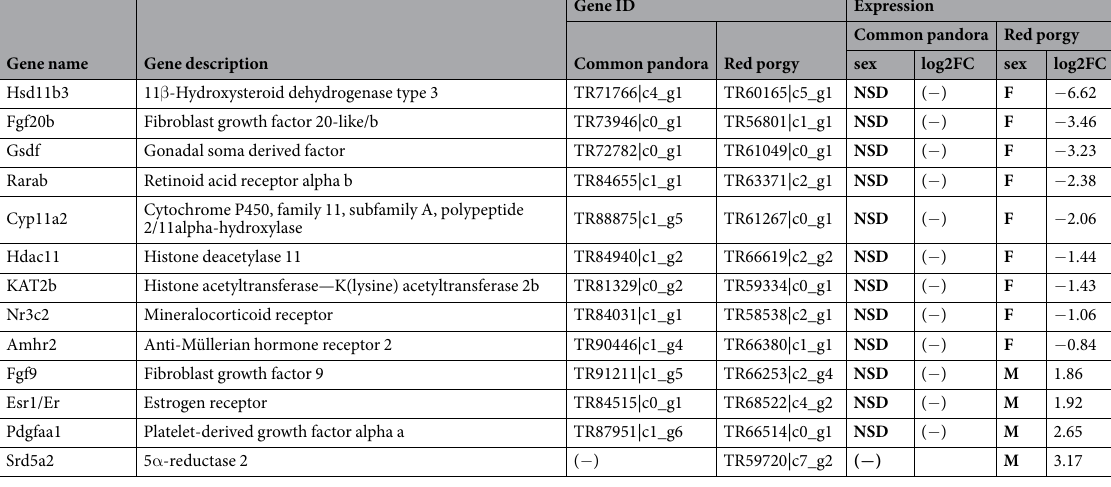
Table 1. Expression pattern of gonadal genes implicated in sex determination/differentiation of common pandora and red porgy. M: male-biased, F: female-biased, NSD: not significantly